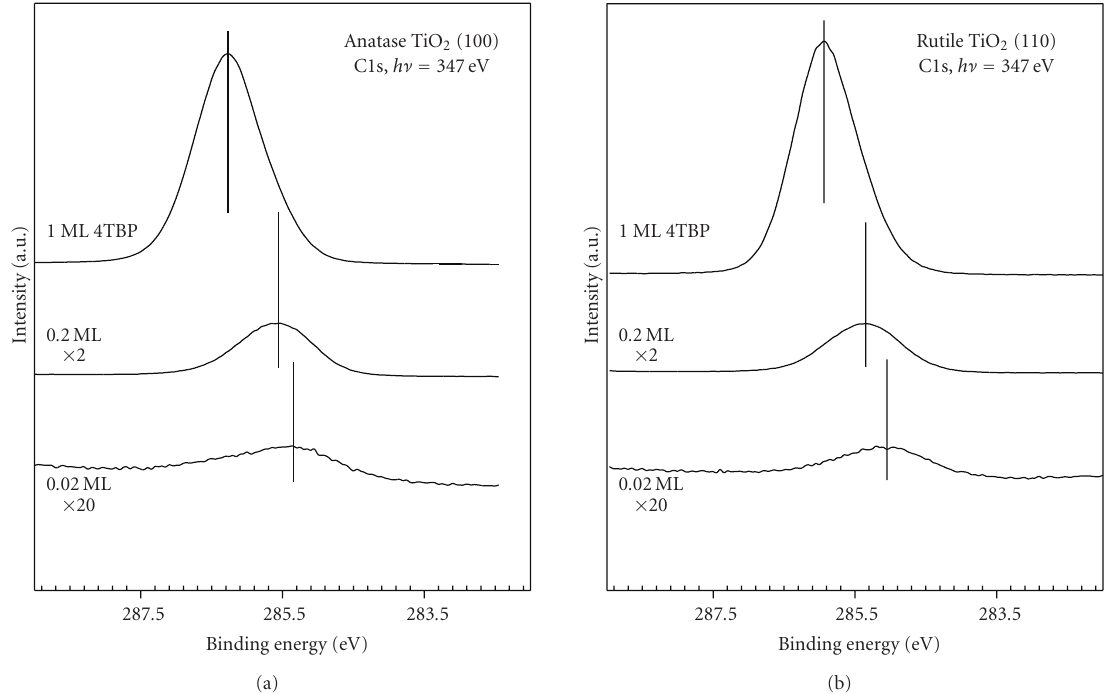
Figure 3: C1s spectra from 4TBP at di ff erent coverages. Incident photon energy